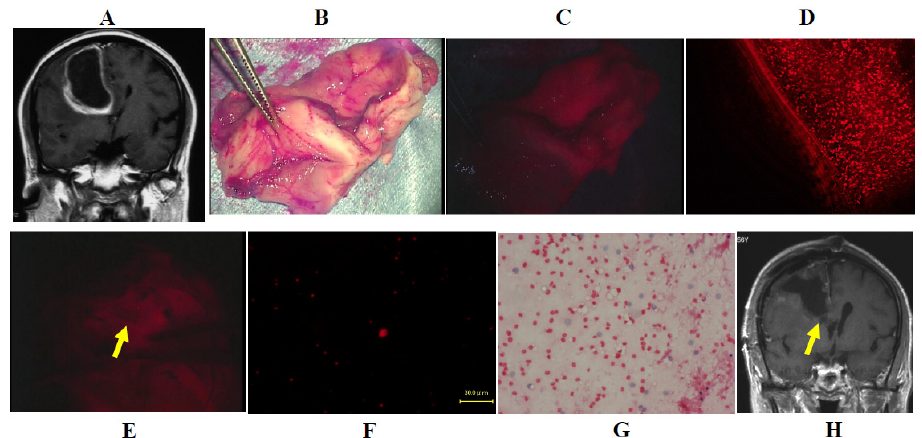
Figure 4. Illustrative case one. ( A ): Gadolinium-enhanced T1-weighted coronal image demonstrating a strongly enhanced cystic glioblastoma lesion in the right frontal lobe. ( B ): Brain tissue containing the tumor tissue was resected completely using an optical navigation system under continuous motor evoked potential monitoring. ( C ): Strong fluorescence from the resected tumor tissue was detected under a surgical microscope during photodiagnosis. ( D ): A total of 761 cells emit- ting fluorescence were detected in the tumor issue under the fluorescence microscopy using the Cy 5 filter. ( E ): Weak fluorescence (yellow arrow) was detected in the marginal brain tissue under surgical microscopy. ( F ): A total of 61 cells emitting fluorescence were detected in the marginal brain tissue under fluorescence microscopy using the Cy 5 filter. ( G ): Hematoxylin and eosin staining of a crush smear sample of the same tissue same as in ( F ). ( H ): Gadolinium-enhanced T1- weighted coronal image after surgery demonstrating complete resection of the tumor bulk and the additional resected area (yellow arrow) of the marginal brain tissue.